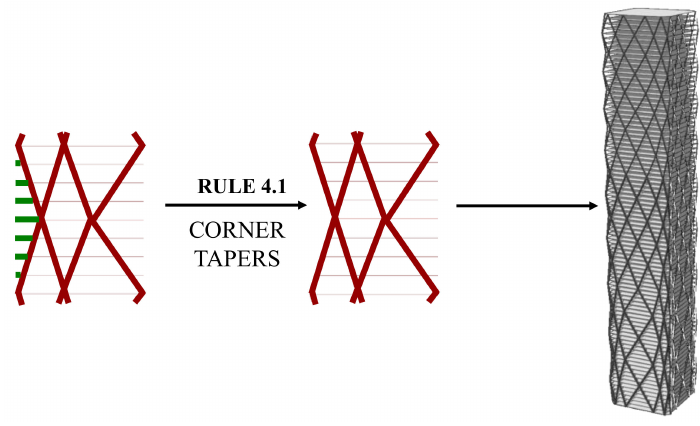
Figure 7. Realisation of the tapered chamfering of the